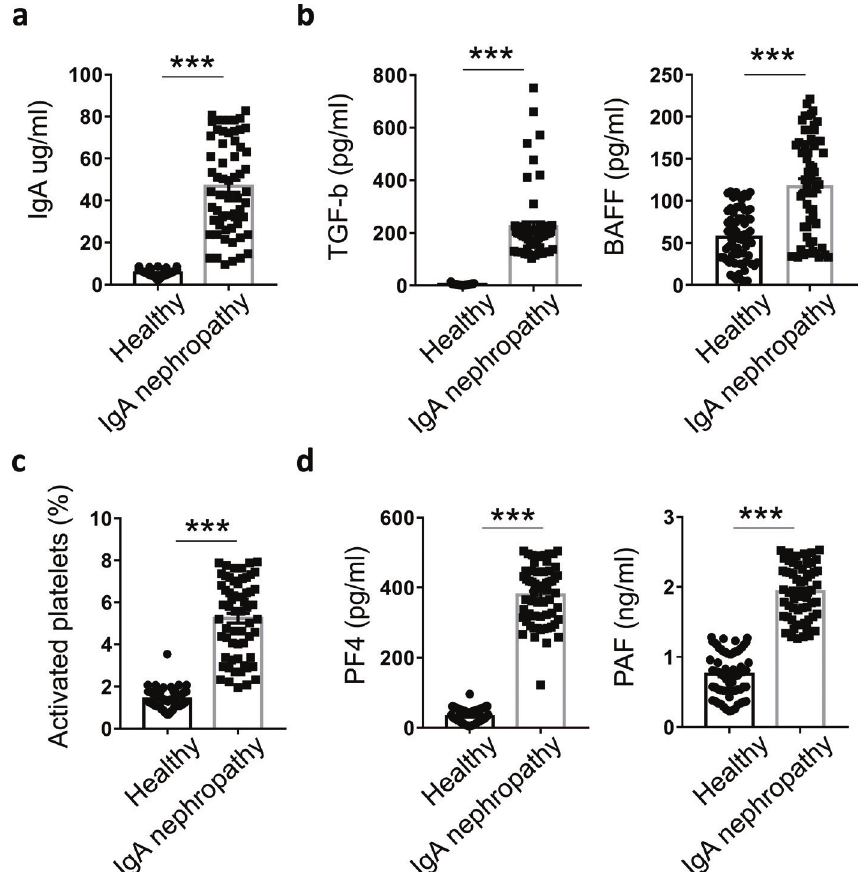
Fig. 1 . Increased IgA and activated platelets were observed in the patients with IgA nephropathy. (a, b) The content of IgA (a), TGF- β and BAFF (b) from the serum of IgA nephropathy patients ( n = 67) or healthy controls ( n = 61) were assessed by ELISA. (c) Platelet activation induced with phorbol-12-myristate-13-acetate (PMA). (d) The protein levels of PF4 and PAF in the serum of IgA nephropathy patients or healthy controls were assessed by ELISA. The data were expressed as means ± standard error of mean (SEM). Results represent mean values of three independent experiments. ***, P <